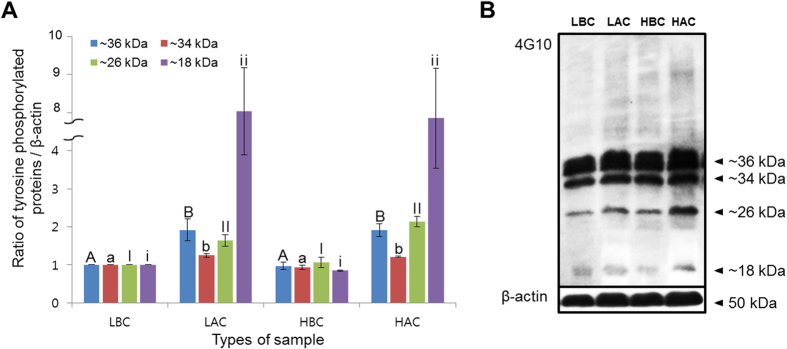
Levels of tyrosine phosphorylation in high- and low-litter size spermatozoa following capacitation.(A) Ratios of tyrosine phosphorylated protein (optical density [OD] × mm)/β-actin (OD × mm) (blue bar: ~36 kDa, red bar: ~34 kDa, green bar: ~26 kDa, purple bar: ~18 kDa; LBC: low-litter size spermatozoa before capacitation, LAC: low-litter size spermatozoa after capacitation, HBC: high-litter size spermatozoa before capacitation, HAC: high-litter size spermatozoa after capacitation). Data represent the mean ± SEM, n = 3. Values with different superscripts (A,B, a, b, I, II, i, ii) were significantly different (P < 0.05). (B) Tyrosine phosphorylated proteins were probed with anti-phosphotyrosine (4G10) antibody. Lane 1: low-litter size spermatozoa before capacitation, lane 2: low-litter size spermatozoa after capacitation, lane 3: high-litter size spermatozoa before capacitation, lane 4: high-litter size spermatozoa after capacitation.